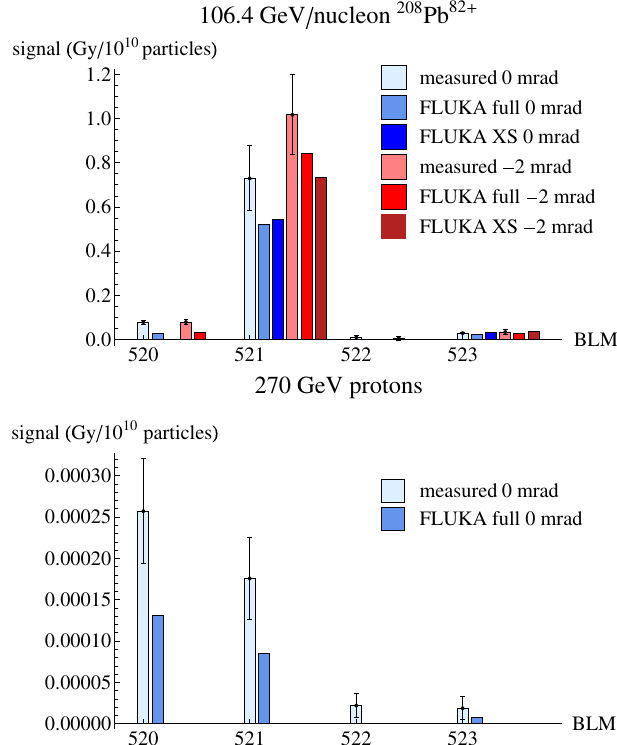
FIG. 13. (Color) Average loss map for 106 : 4 GeV = nucleon 208 Pb 82 þ ions (top) and 270 GeV protons (bottom) with parallel jaws (blue bars) and jaws tilted by 2 mrad (red bars). The measurements are compared with simulations using both meth- ods of simulating the particle-matter interaction in the collima- tor, as described in the text. All results were normalized to 10 10 lost particles. The standard deviation between different measure- ments is